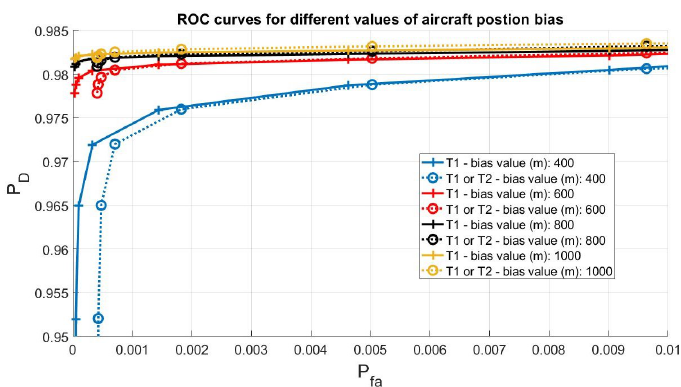
Figure 4. Receiver Operating Characteristic for T1 and T2 different bias